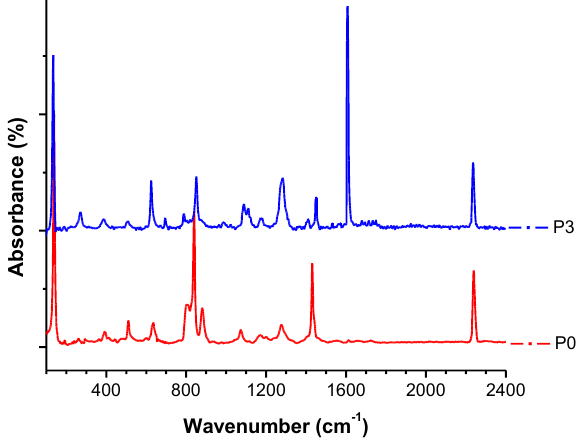
Figure 9. FTIR spectra of the neat sample and the sample after modification.